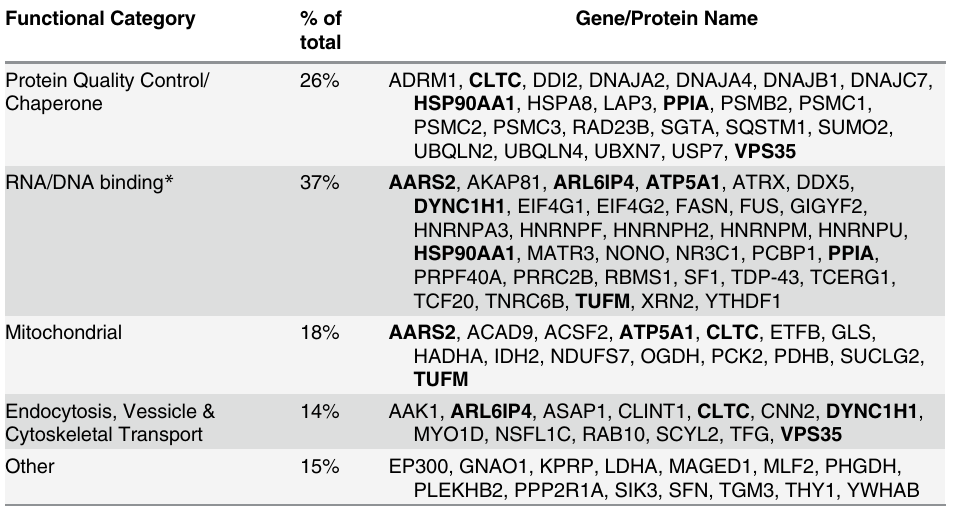
Table 2. Molecular function of proteins associated with Htt-polyQ aggregates as identified by TAPI (N = 91) in Rattus norvegicus . Functional